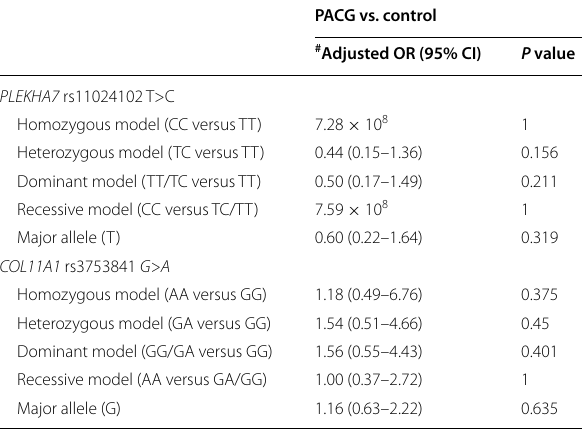
PLEKHA7 Pleckstrin homology domain-containing family A member 7, COL11A1 collagen 11 A1, OR odds ratio, 95% CI 95% confidence